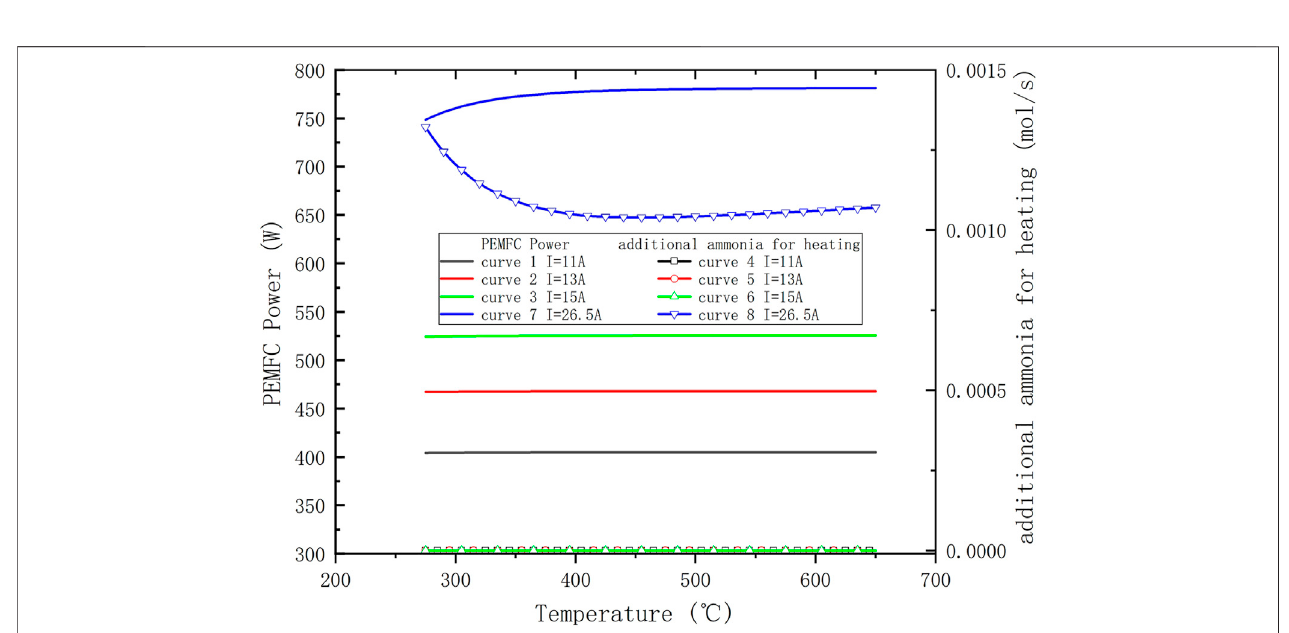
FIGURE 4 | Variation of PEMFC power and amount of additional fuel with temperature at different current.